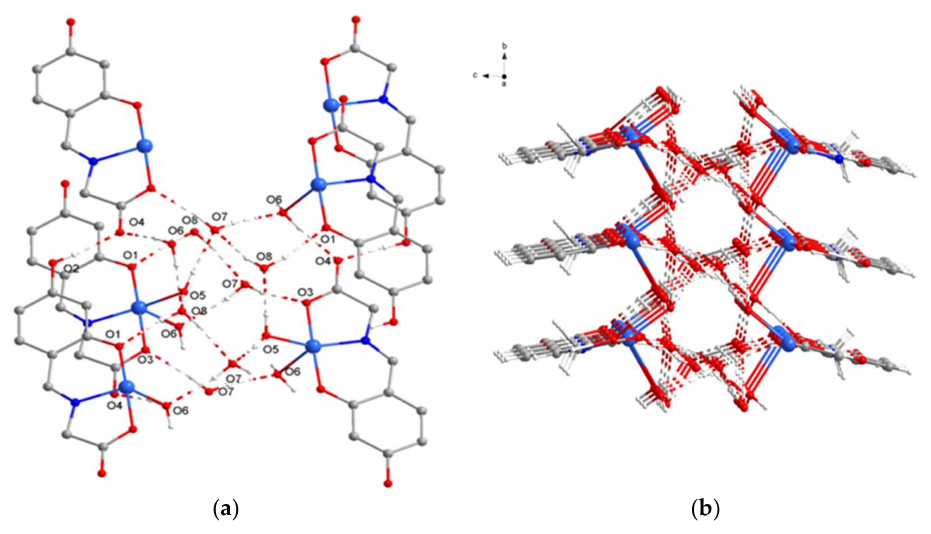
Figure 5. ( a ) The intermolecular O–H . . . O hydrogen bonds; ( b ) Representation of the 2D topologies of Complex 1 . Hydrogen bonds are shown as dashed